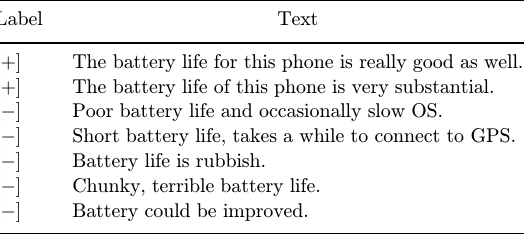
Table 1. Example on sentiment classi¯cation with respect to the concept battery life. Label